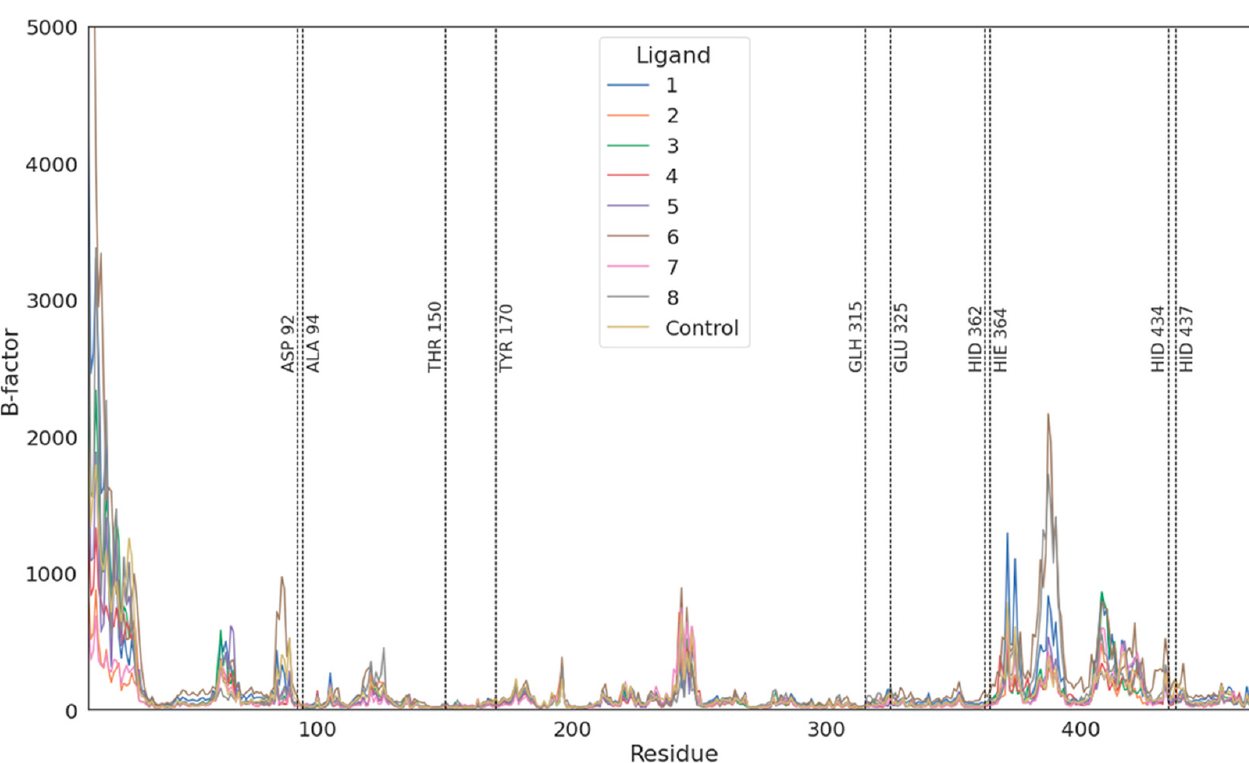
Figure 6. Fluctuations of residues 20–450 during simulations. Vertical lines indicate residues in the binding vicinity. There are major shifts nearby residues 250, 320 and 420, which are regions voiding any secondary structures.